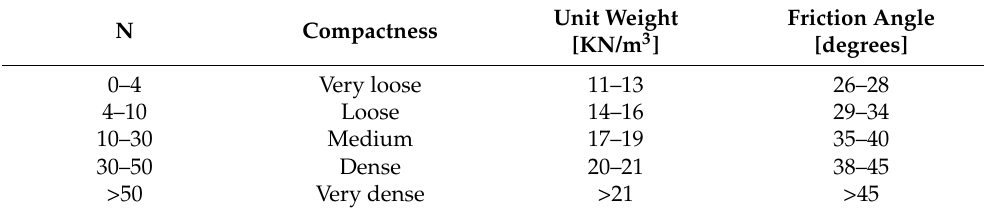
Table 1. Correlation of SPT values for coarse-grained soils (from